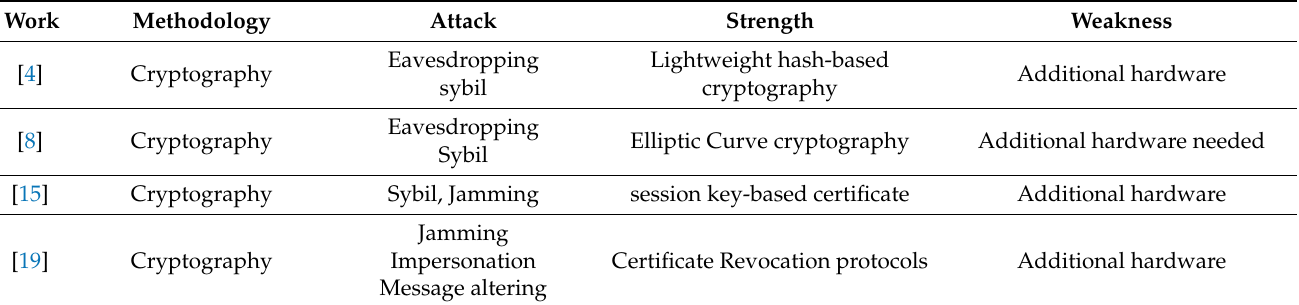
Table 2. A Comparative Summary of Security